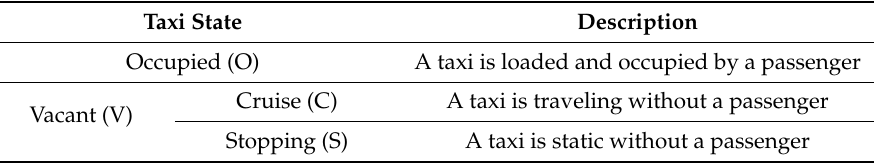
Table 2. Description of each taxi state.